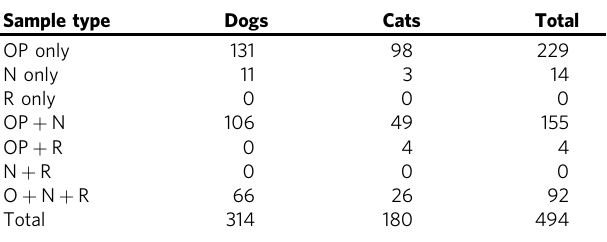
Table 1 Sample type distribution for detection of SARS-CoV-2